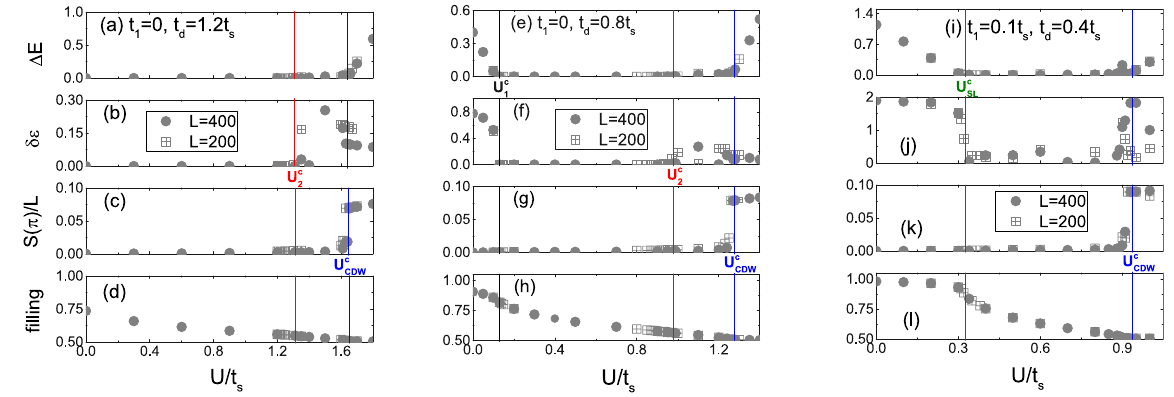
), red circles ( U c ), green stars ( U c ), and blue triangles 1 2 SL